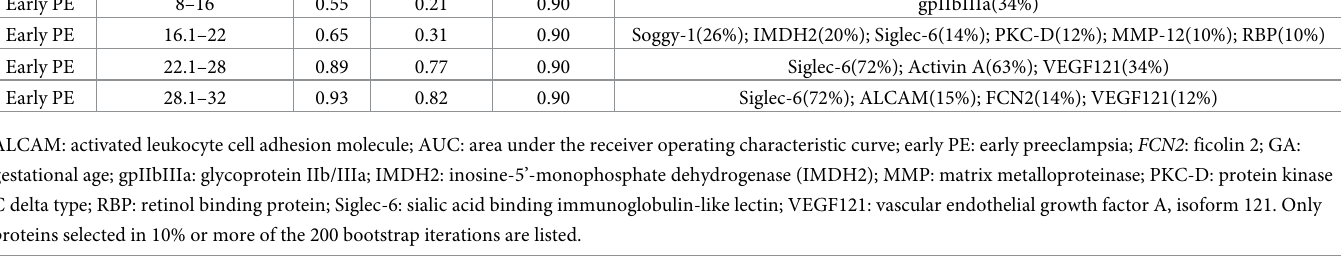
S2 Table presents the linear fold changes of MoM values between the early preeclampsia and normal pregnancy groups as well as the nominal and FDR-adjusted p-values (q-values) for each gestational-age interval. Additionally, the heatmap presented in Fig 7 summarizes the